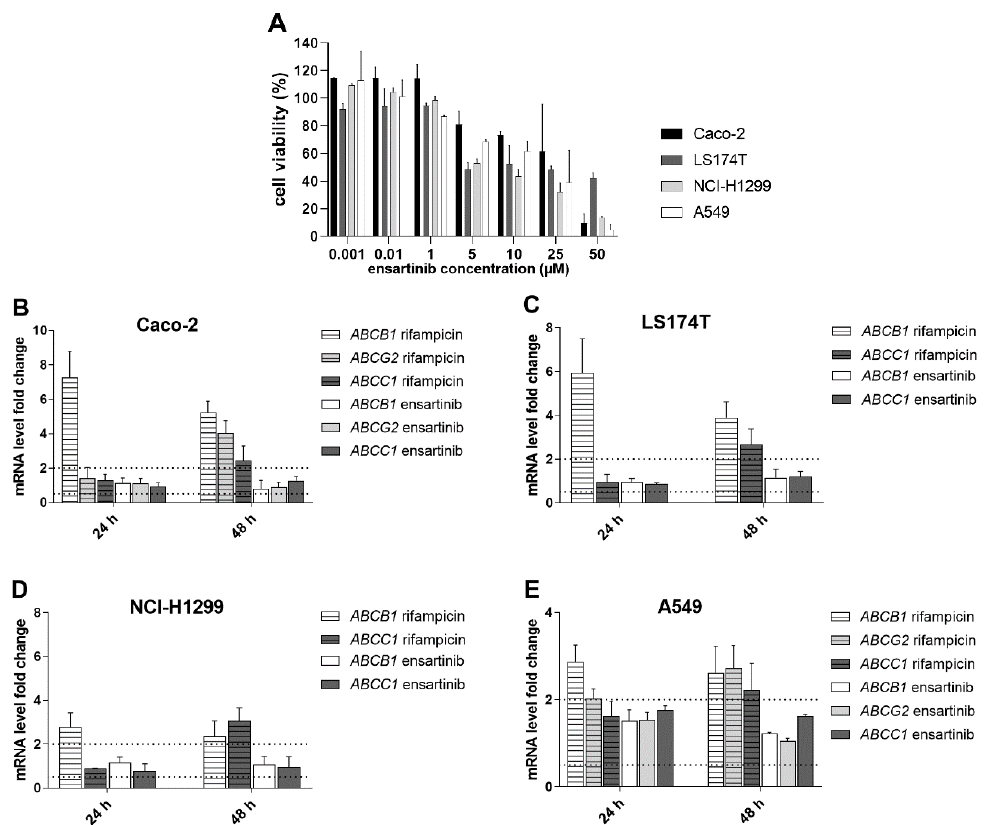
Figure 11. Changes in ABCB1 , ABCG2 , or ABCC1 mRNA levels in physiological Caco-2 and LS174T cells ( B , C ) and non-small cell lung cancer (NSCLC) cellular models ( D , E ) after treatment with ensartinib. The tested drug concentration was chosen based on the results of MTT viability experiments ( A ) and previously determined Cmax values. During the gene induction assays, the cells were incubated with 0.5 µM ensartinib or 25 µM rifampicin for 24 and 48 h, and the mRNA levels of target genes were evaluated by qRT-PCR. ABCG2 was not detectable in LS174T and NCI-H1299 cells. The boundaries of downregulation/upregulation positivity based on the EMA’s recommendations are indicated by dotted lines. The plotted data are means ± SD from at least three independent experiments.